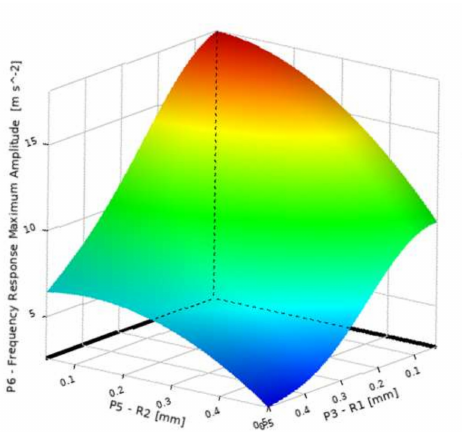
Figure 11. Response surface of the PM